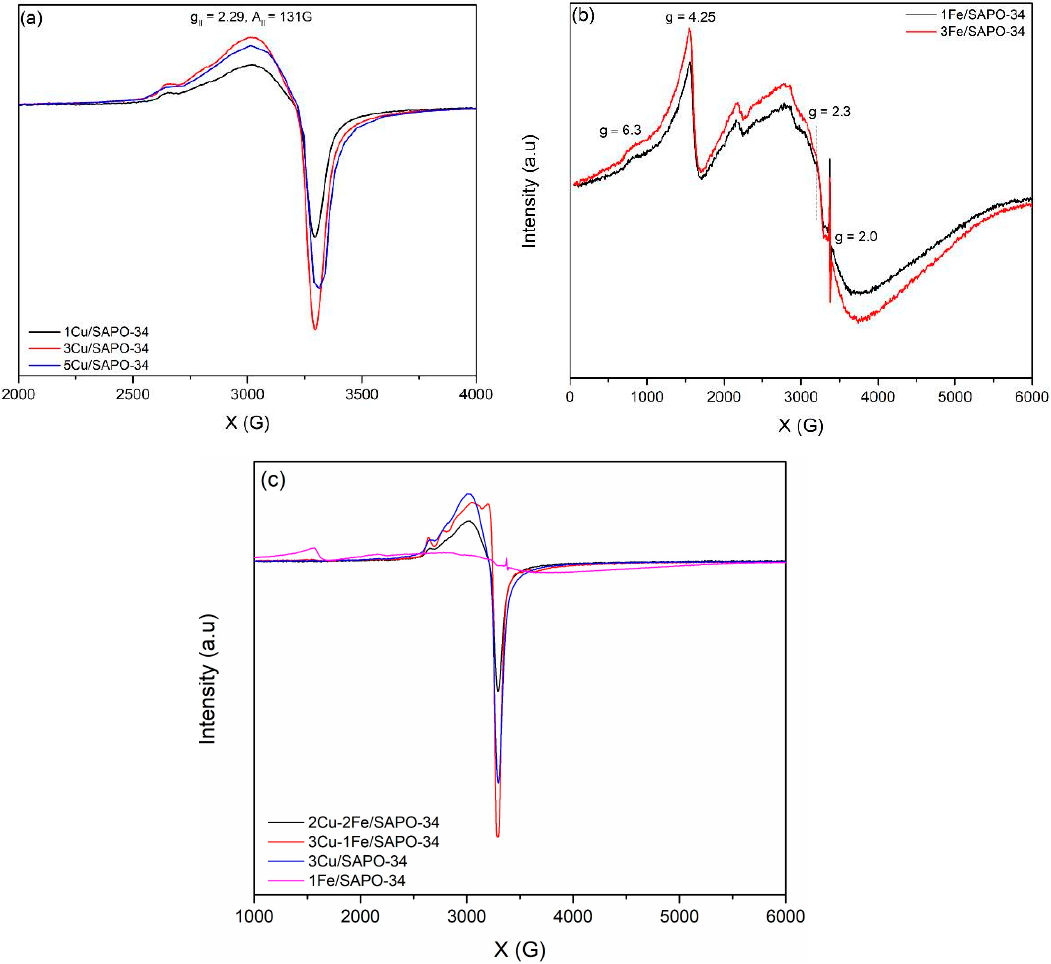
Figure 7. EPR spectra of ( a ) Cu / SAPO-34, ( b ) Fe / SAPO-34, and ( c ) Cu-Fe / SAPO-34 series catalysts measured at 100 K.